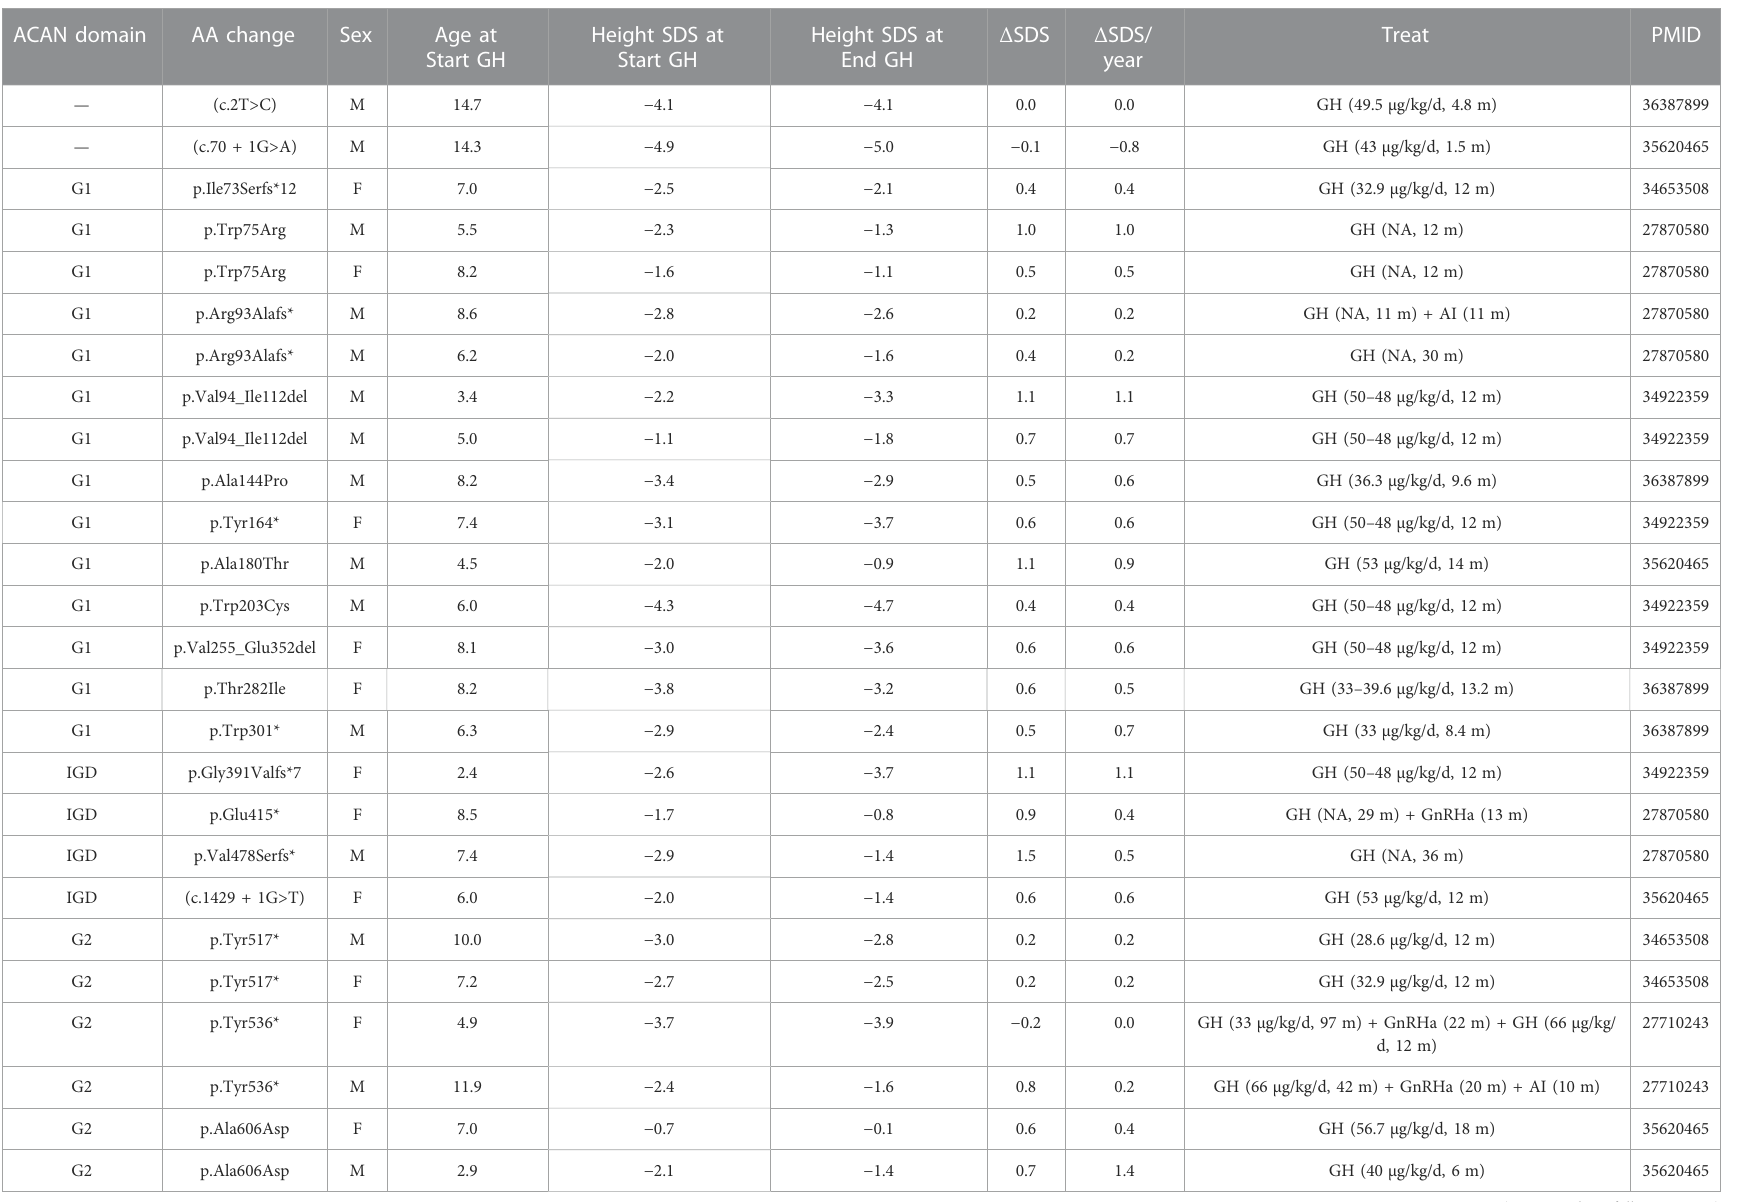
TABLE 1 Summarized of reported ACAN patients and their prognosis data during GH